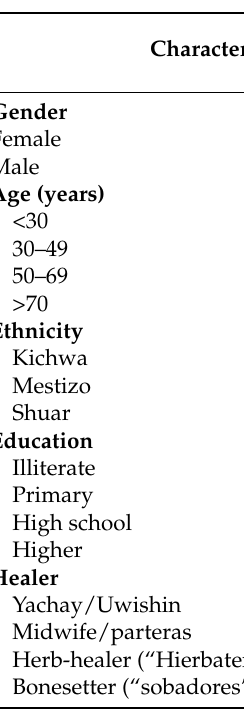
Table 3. Socio-demographic characteristics and focus